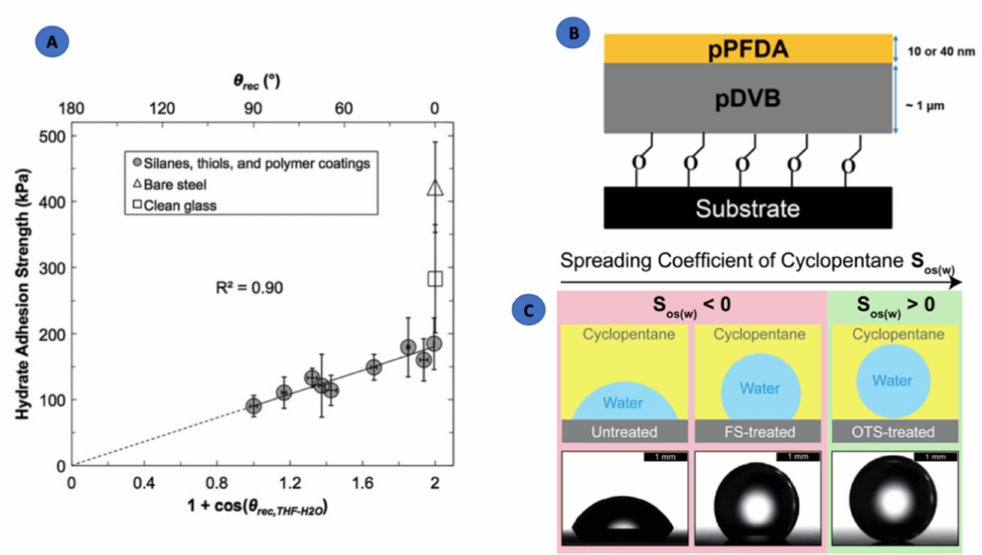
Figure 2. ( A ) Correlation between hydrate adhesion strength with the practical work of adhesion evaluated using the 19.1 wt.% THF in water solution on various functionalized surfaces. ( B ) A linker-grafted pPFDA/pDVB polymeric ice-phobic, hydrate-phobic, and hydrophobic coating. ( C ) Representation of water contact angles on solid surfaces (s), indicating two zones of spreading coefficient, S os(w) of cyclopentane (o) in presence of water (w). ( A ) Reprinted with permission from ref. [40]. ©2012 Royal Society of Chemistry. ( B ) Reprinted with permission from ref. [43]. ©2015 American Chemical Society.and ( C ) Reprinted with permission from ref. [46]. ©2017 American Chemical